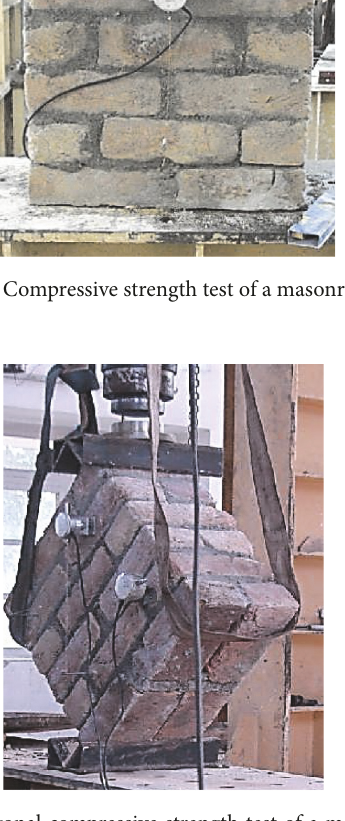
Figure 3: Diagonal compressive strength test of a masonry speci-